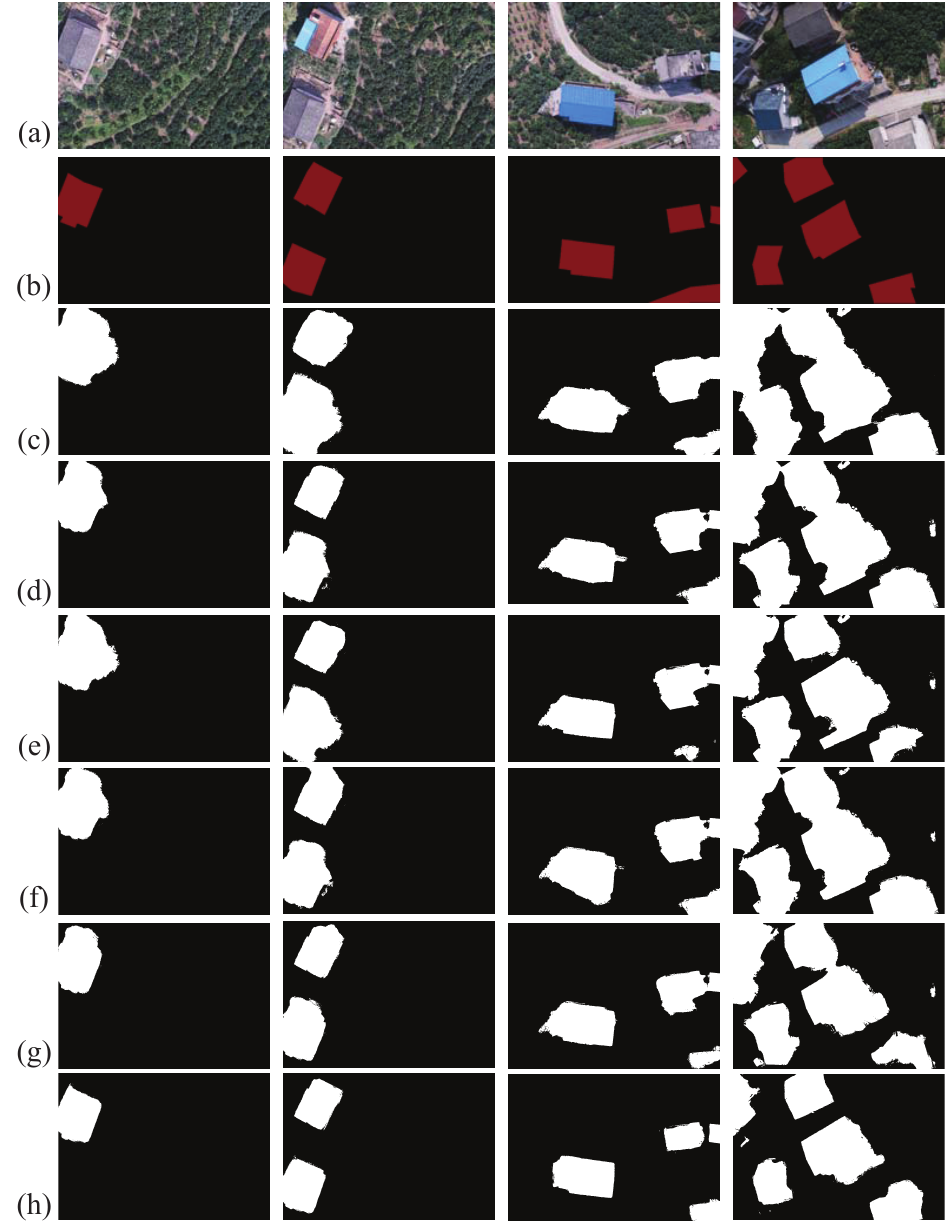
Figure 10. Qualitative comparison of segmentation results on Majiagou test set. ( a ) Images; ( b ) ground-truth; ( c ) AffinityNet; ( d ) IRN; ( e ) SEAM; ( f ) BES; ( g ) AdvCAM; and ( h )